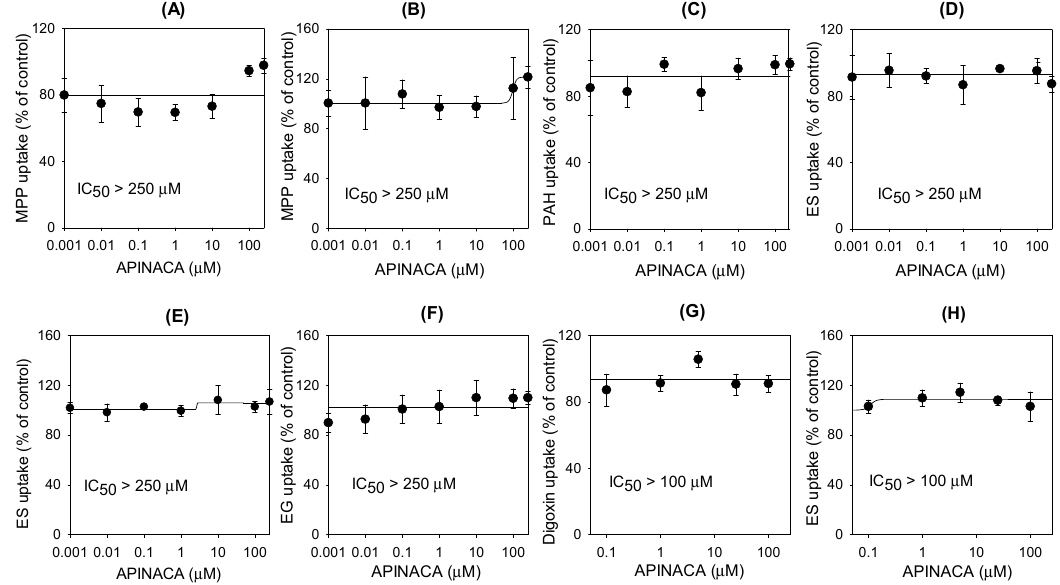
Figure 6. Inhibitory effect of APINACA on the transport of the probe substrates in ( A ) HEK293-OAT1, ( B ) HEK293-OAT3, ( C ) HEK293-OCT1, ( D ) HEK293-OCT3, ( E ) HEK293-OATP1B1, ( F ) HEK293-OATP1B3, ( G ) LLC-PK1-MDR1, and ( H ) LLC-PK1-BCRP cells. The concentrations and probe substrates were selected as follows: 0.1 µ M [3-H]methyl-4-phenylpyridinium (for OCT1 and OCT2), 0.1 µ M [3-H]para-aminohippuric acid (for OAT1), 0.1 µ M [3-H]estrone-3-sulfate (for OAT3, OATP1B1, and BCRP), 0.1 µ M [3-H]estradiol-17 β - d -glucuronide (for OATP1B3), and 0.1 µ M [3-H]digoxin (for P-glycoprotein (P-gp)). The data are the means ± SD ( n =